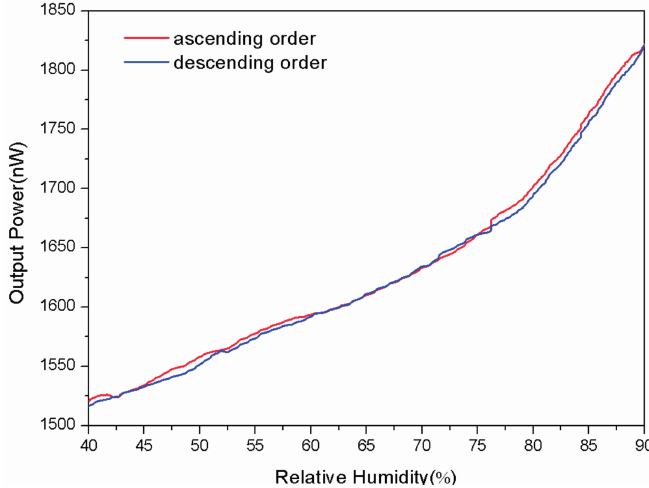
Figure 5. The reversibility of the proposed sensor with a bend radius of 8